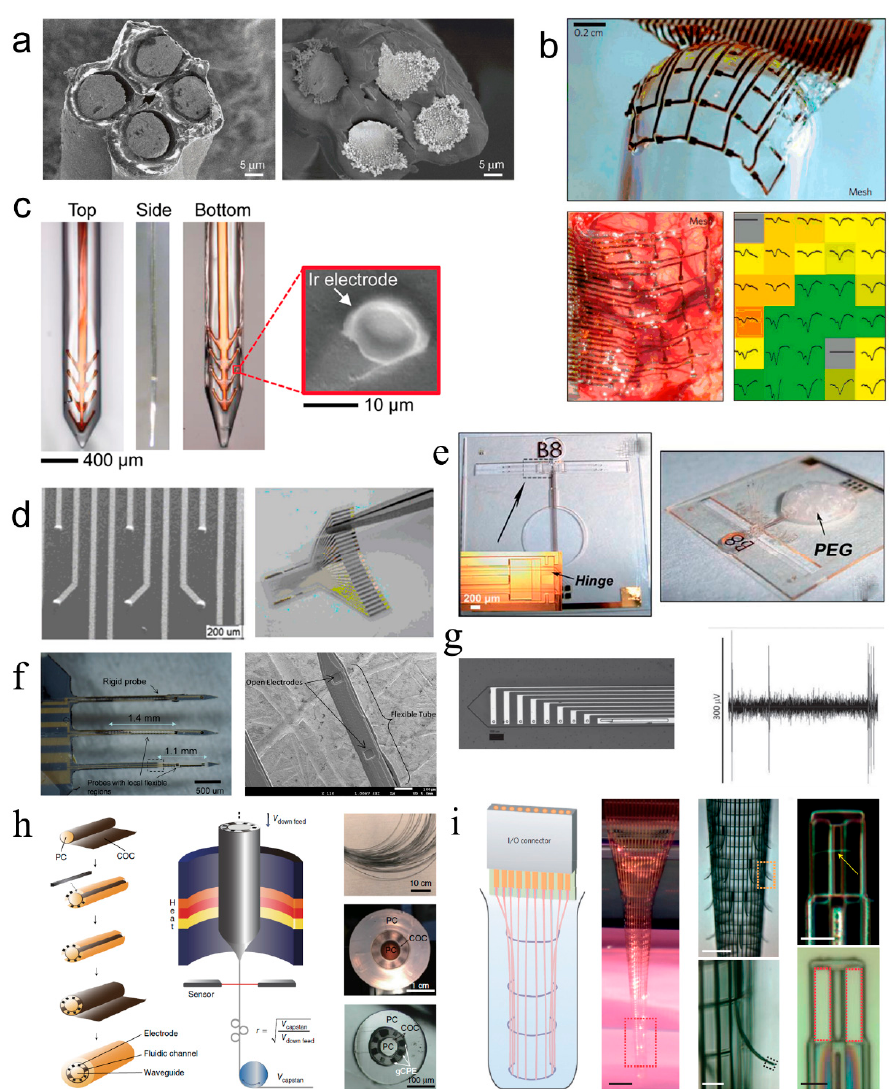
Figure 4. Research progress of flexible MEMS microelectrodes for neural interface, ( a ) Tetrode composed of four micro wire electrodes, reprinted from [36] with permission of Elsevier, Copyright 2009; ( b ) Thin film microelectrode array with silk fibroin covered as substrate reprinted from [37] with permission